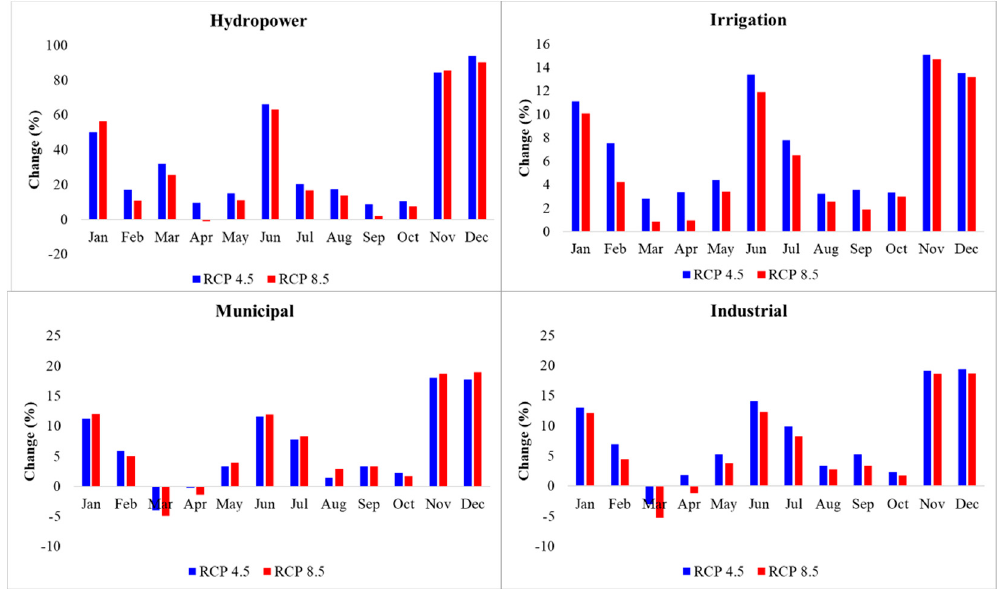
Figure 6. Changes in energy generation (GWh), as well as the percentage of demand met by dams from the irrigation, municipal, and industrial sectors from 2021 to 2099 as a result of climate change, as calculated using four climate models under RCP 4.5 and RCP 8.5.